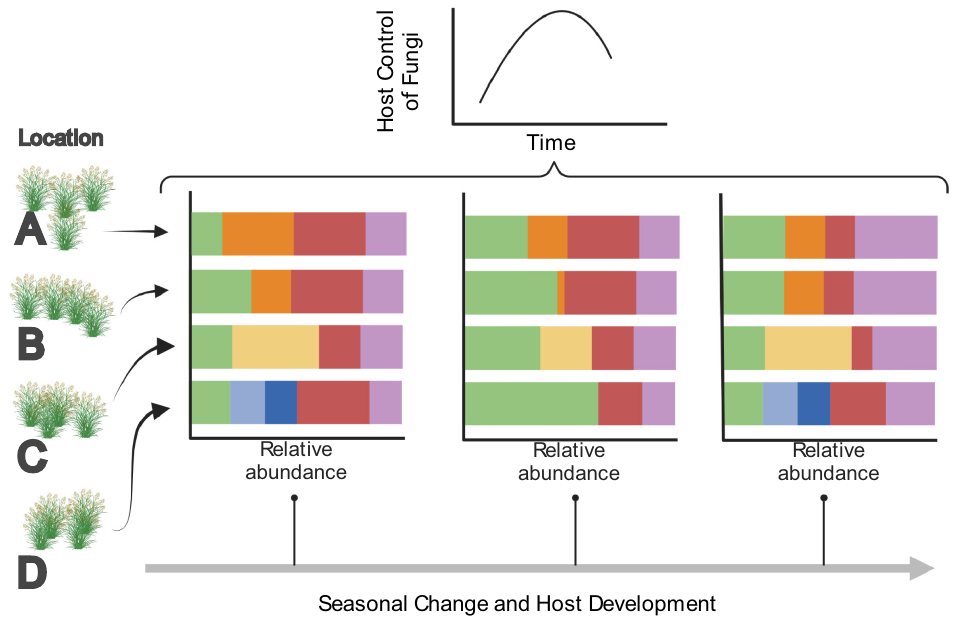
Fig 1. Genetic control of the fungal microbiome changes through time. Schematic of experimental setup and measurements taken. The same switchgrass genotypes were grown at 4 different field sites, and their fungal microbiomes were sequenced repeatedly throughout the growth season. The authors found that the influence of genetics on the fungal community was not static, instead changing over time. Created with BioRender.com.